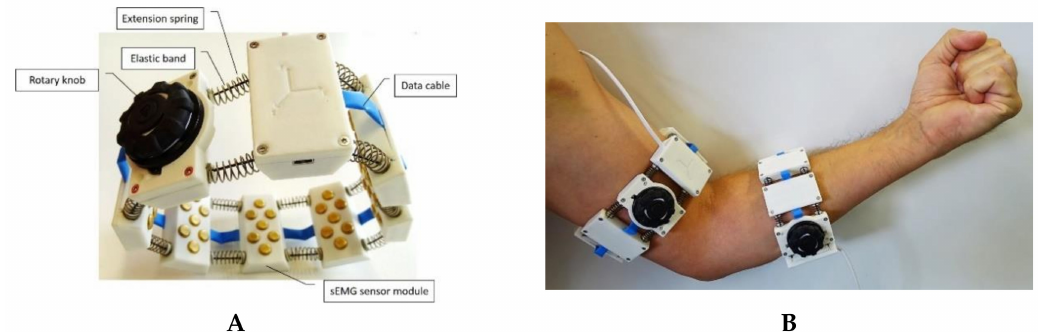
Figure 1. sEMG sensor system. ( A ) 8 independent sEMG sensor modules are arranged in a ring to form a rotation-symmetrical armband. The individual sEMG sensor modules are connected by elastic bands and extension springs. The size of the sEMG sensor system can be individually adjusted by the rotary knob. ( B ) An example showing the application of two sEMG sensor systems for monitoring the muscular activation of upper arm and forearm